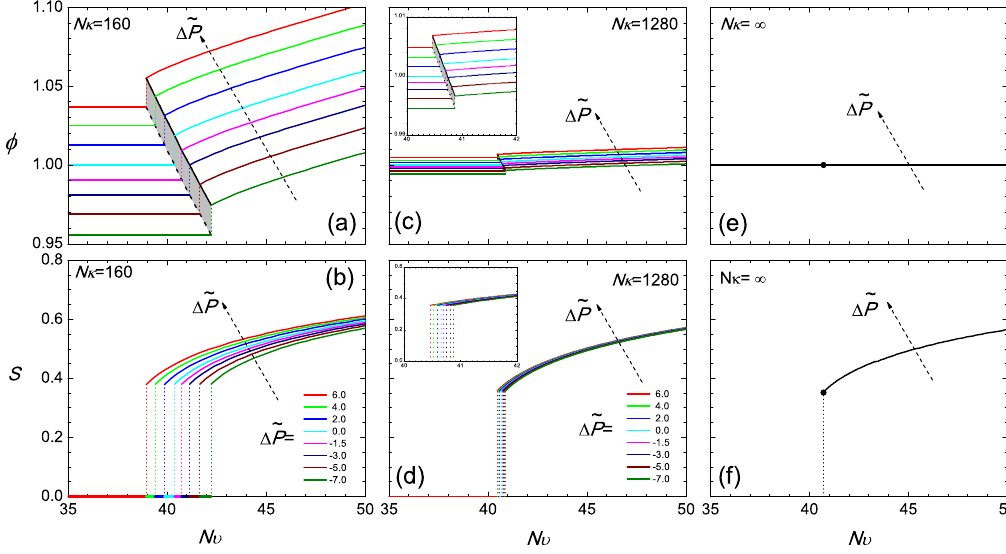
Figure 3. The isobaric volume fraction φ ( a , c , e ) and the isobaric orientational order parameter S ( b , d , f ), as a function of N υ across the transition region for N κ = 160,1280 and ∞ . The value of the reduced ∆ ˜ P is specified in Plot ( b ). In this phase diagram, the coexistence region is